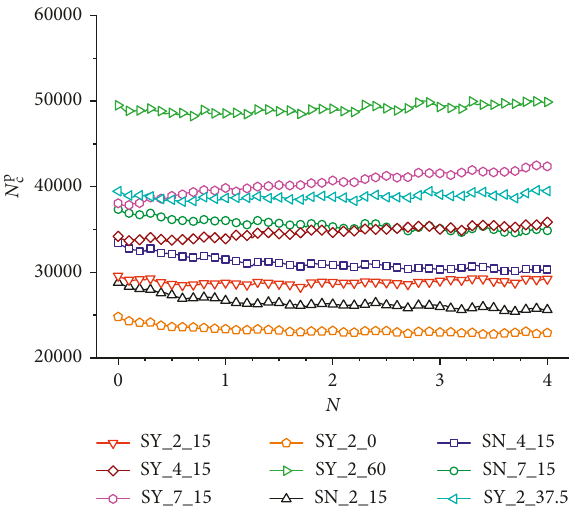
Figure 23: Evolution of the total number of contacts between particles ( N p c